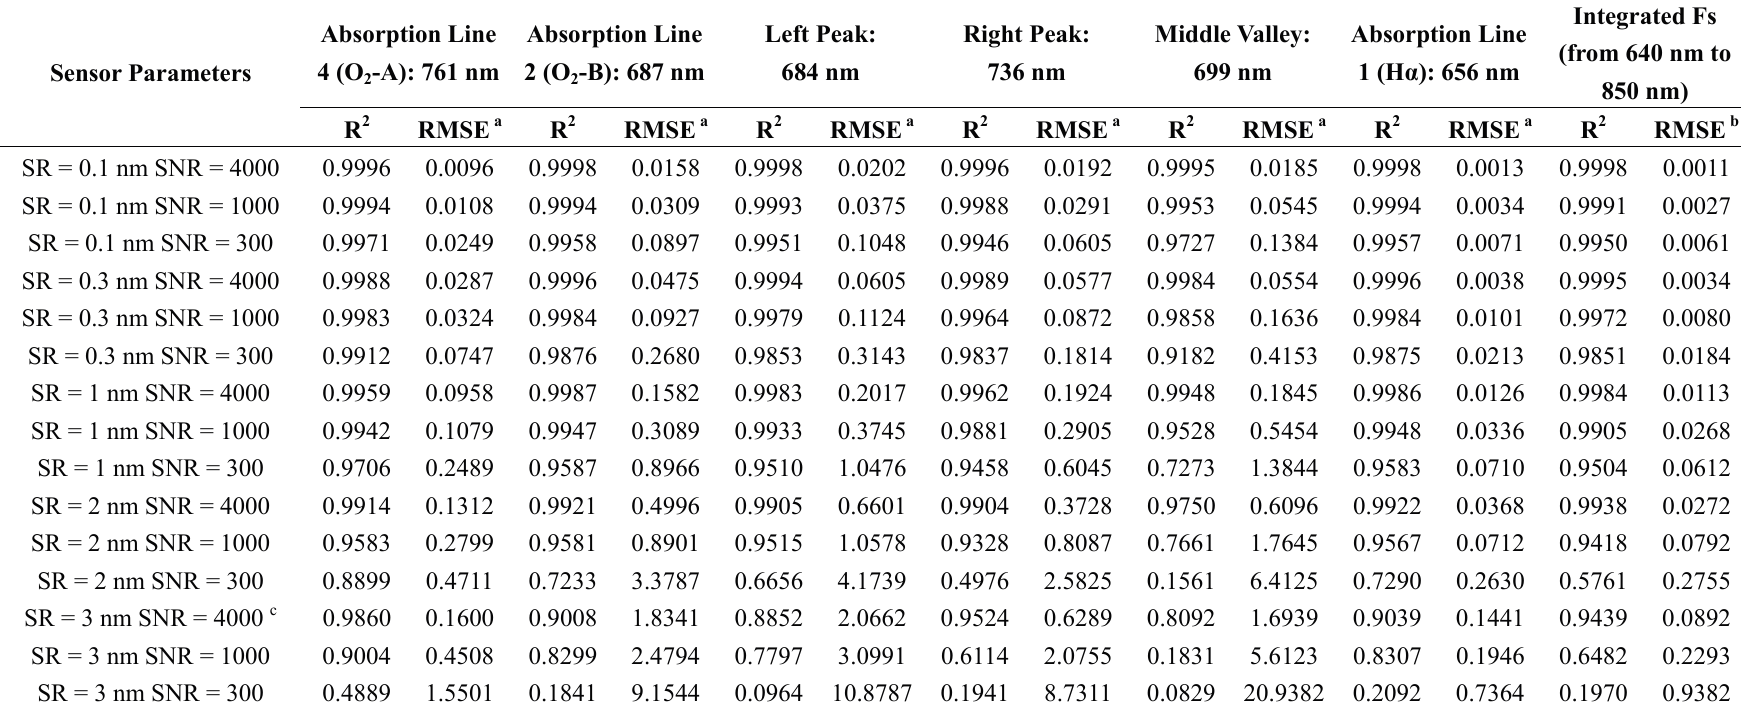
Table 3. The accuracy of the FSR method assessed with noisy and different SR datasets (Dataset III) under different sensor configurations. Five Spectral Resolution (SR) values (0.1 nm, 0.3 nm, 1 nm, 2 nm, and 3 nm) and three Signal to Noise Ratio (SNR) levels (4000, 1000, and 300) were considered. The coefficient of determination (R 2 ) and the Root-Mean-Square Error (RMSE) between the retrieved and “true” Fs values at 761 nm, 687 nm, 656 nm, 699 nm, 684 nm, and 736 nm were calculated. R 2 and RMSE values of the Fs integrated over the fluorescence emission bands of 640–850 nm were also listed in the